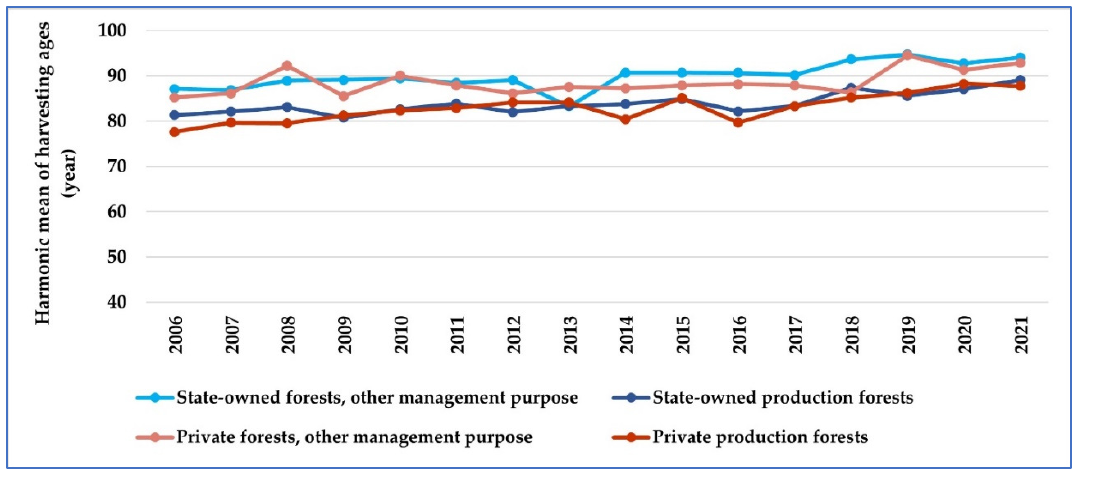
Figure 4. Harmonic mean of harvesting ages (weighted by the area under harvest) of Turkey oak ( Quercus cerris ) stands in the period between 2006 and 2021 grouped by management purpose and ownership.